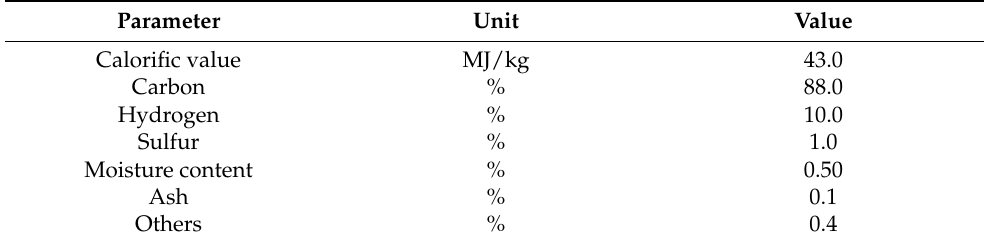
Table 2. Physico-chemical properties of the medium fuel oil. Parameter Unit Value Calorific value MJ/kg 43.0 Carbon % 88.0 Hydrogen % 10.0 Sulfur % 1.0 Moisture content % 0.50 Ash % 0.1 Others %